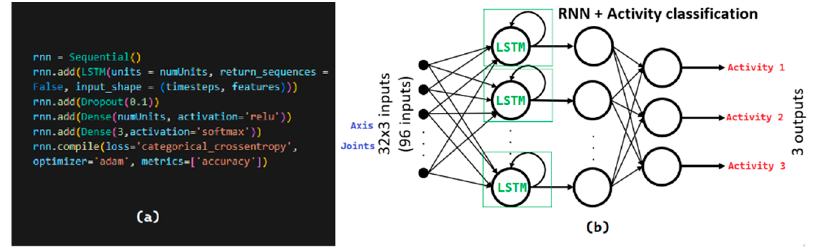
Figure 13. Implemented classification network. ( a ) Python code; ( b ) architecture of neural network.